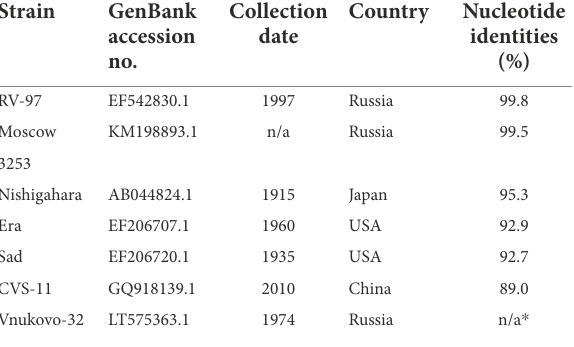
TABLE 2 Rabies virus isolates compared with Shchelkovo-51 strain in glycoprotein gene analysis.